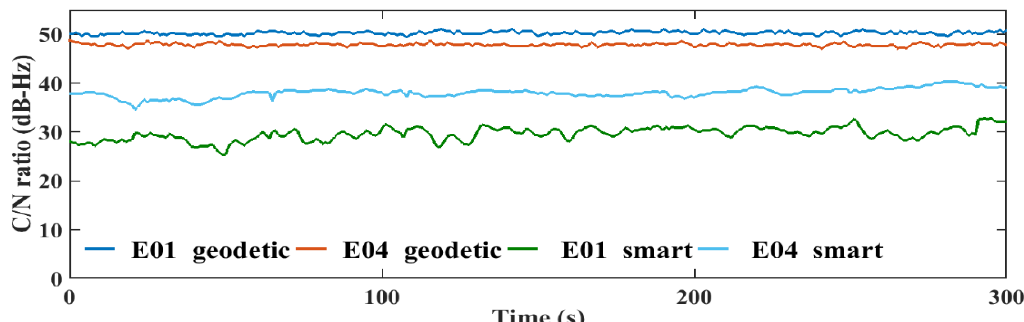
Figure 10. L1 C/N values from the geodetic receiver (geodetic) and the smartphone (smart) for Galileo.